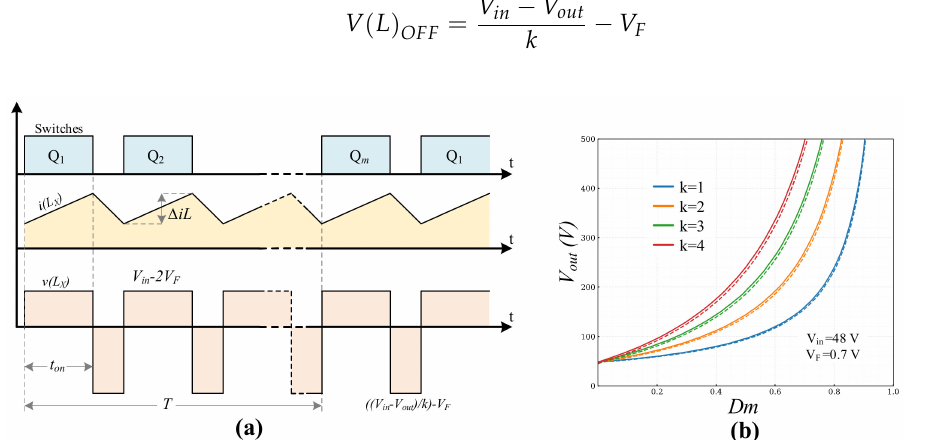
Figure 3. Waveforms and graphic transfer function: ( a ) Current and voltage waveforms in an inductor ( L ) of one inductor from S-Inductor. ( b ) Graphic DC transfer function representation ( V O ) for different numbers of inductors of the S-Inductor ( k ). An input voltage of 48 V and a direct diode drop ( V F ) of 0.7 V are considered. In continuous line, the drop voltage of the diodes is neglected, in dashed line, a 0.7 V voltage drop is